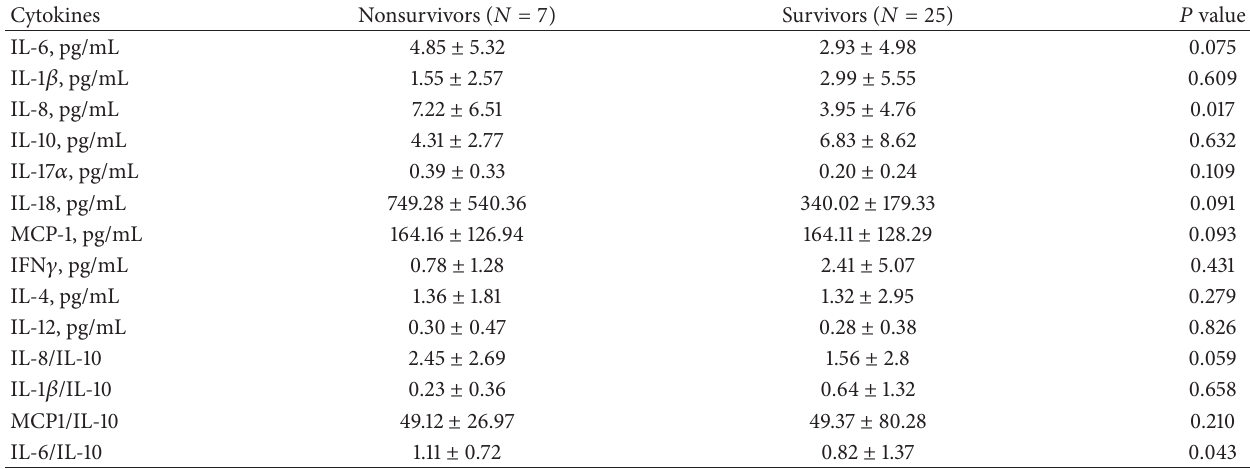
Table 5: Comparisons of cytokines between nonsurvivors and survivors of AIDS PCP